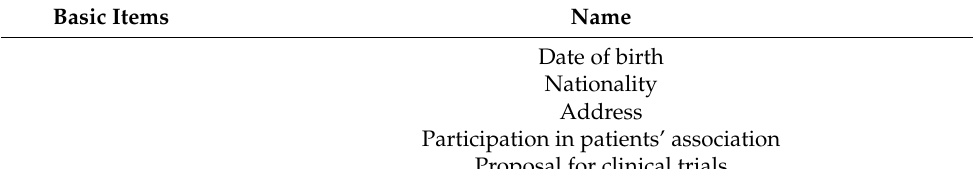
Table 1. Registered fields for the proposed nation-wide OPMD patient registry in